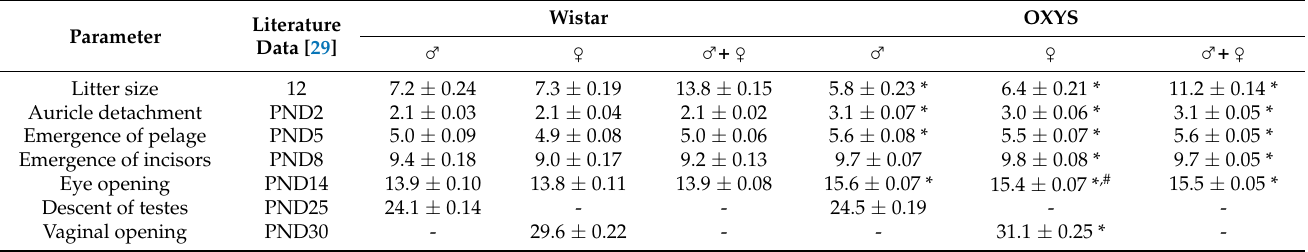
Table 2. Manifestations of phenotypic parameters of OXYS and Wistar rat